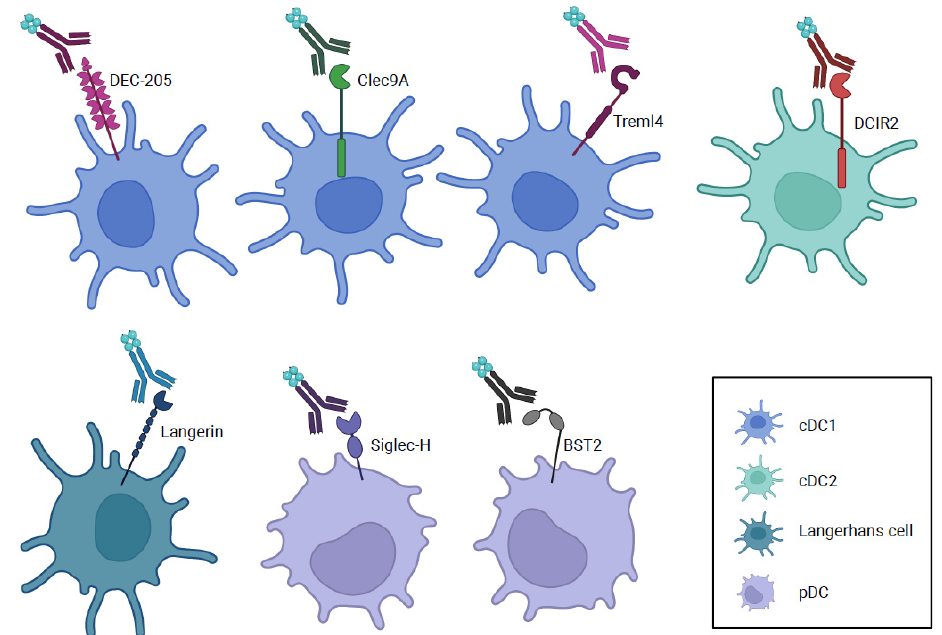
Figure 1. Various receptors used for targeted antigen delivery to dendritic cells. cDC: conventional dendritic cell; pDC: plasmacytoid dendritic cell. dendritic cell; pDC: plasmacytoid dendritic